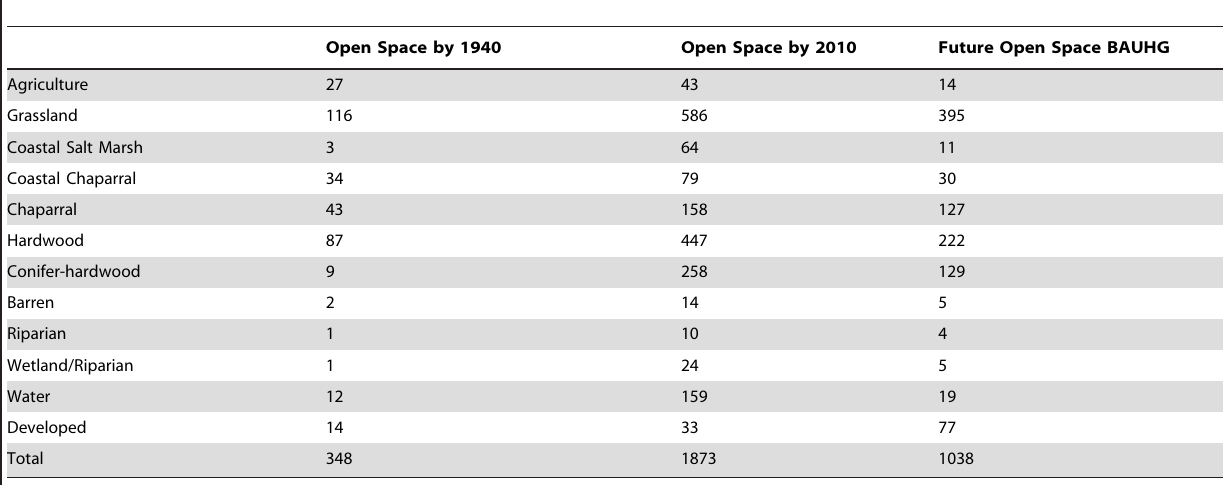
Table 2. Landcover type representation in Open Space areas in the historic (1940), current (2006) and BAUHG future landscapes